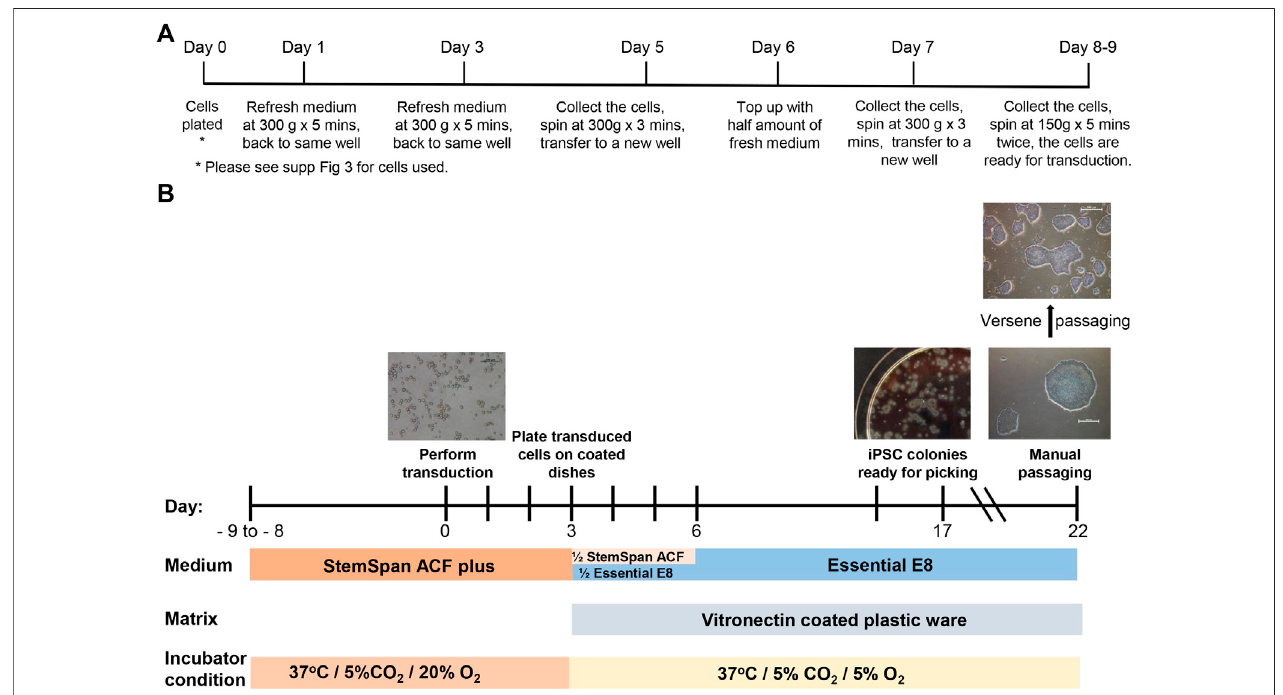
FIGURE 1 | Erythroid cell expansion and reprogramming timeline. (A) The timeline and details of the media refreshing procedure during cell expansion. (B) Major steps of cord blood reprogramming procedure.